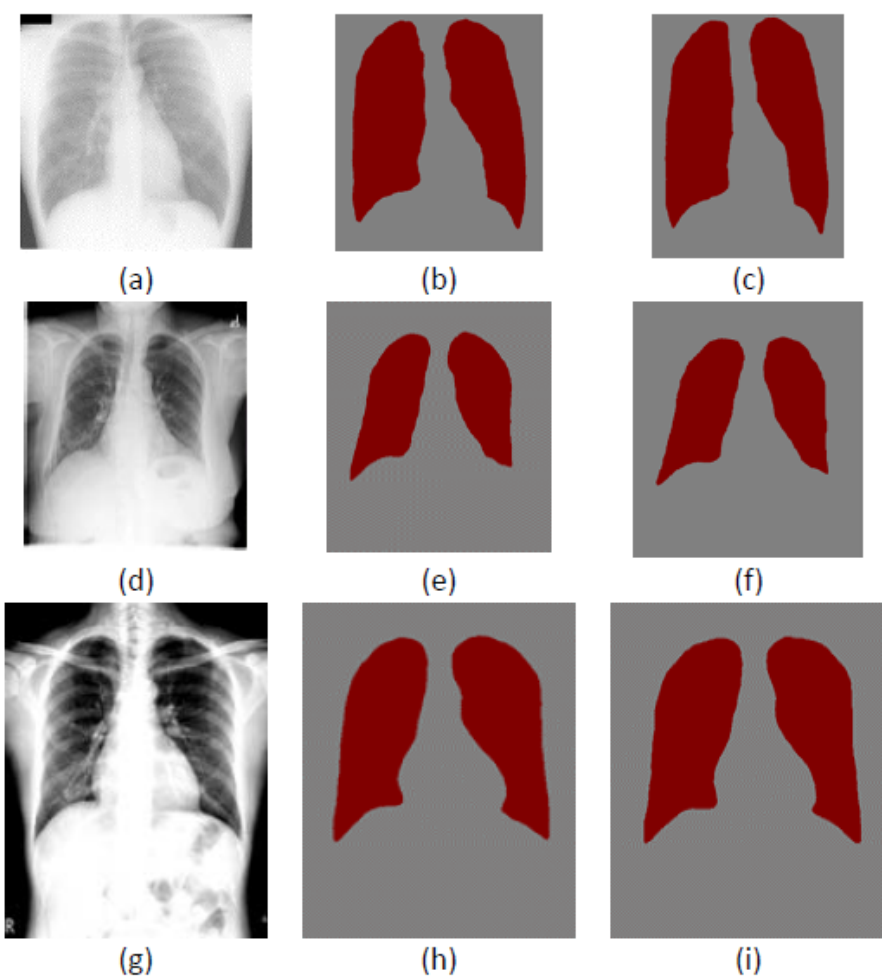
Figure 10. Segmentation results for two resizing algorithms: ( a , d , g ) are images from JSRT, LIDC-IDRI and ANH datasets; ( b , e , h ) are the segmentation result of the JSRT, LIDC, and ANH models using USEQ superpixel interpolation; ( c , f , i ) are the segmentation results of the JSRT, LIDC, and ANH models using bicubic